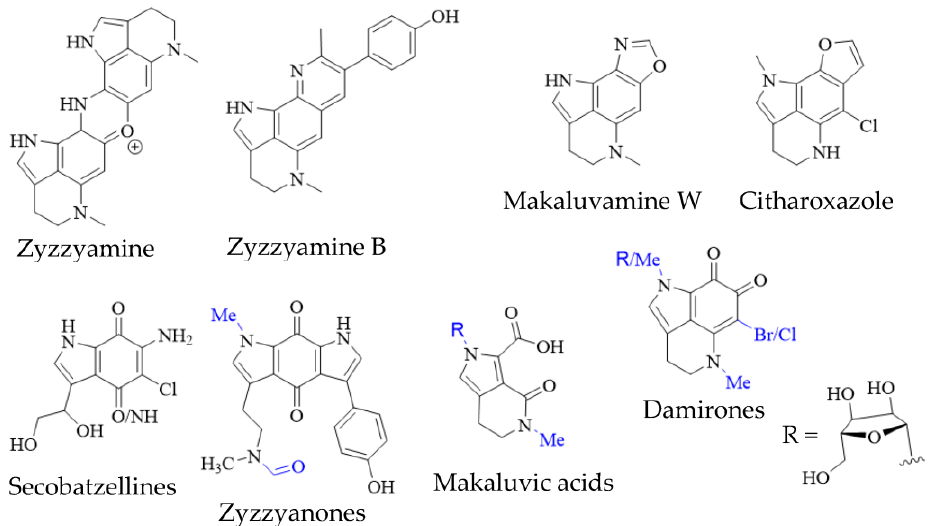
Figure 4. Pyrroloiminoquinone-related marine natural products from sponges. Variable substituents are shown in blue.